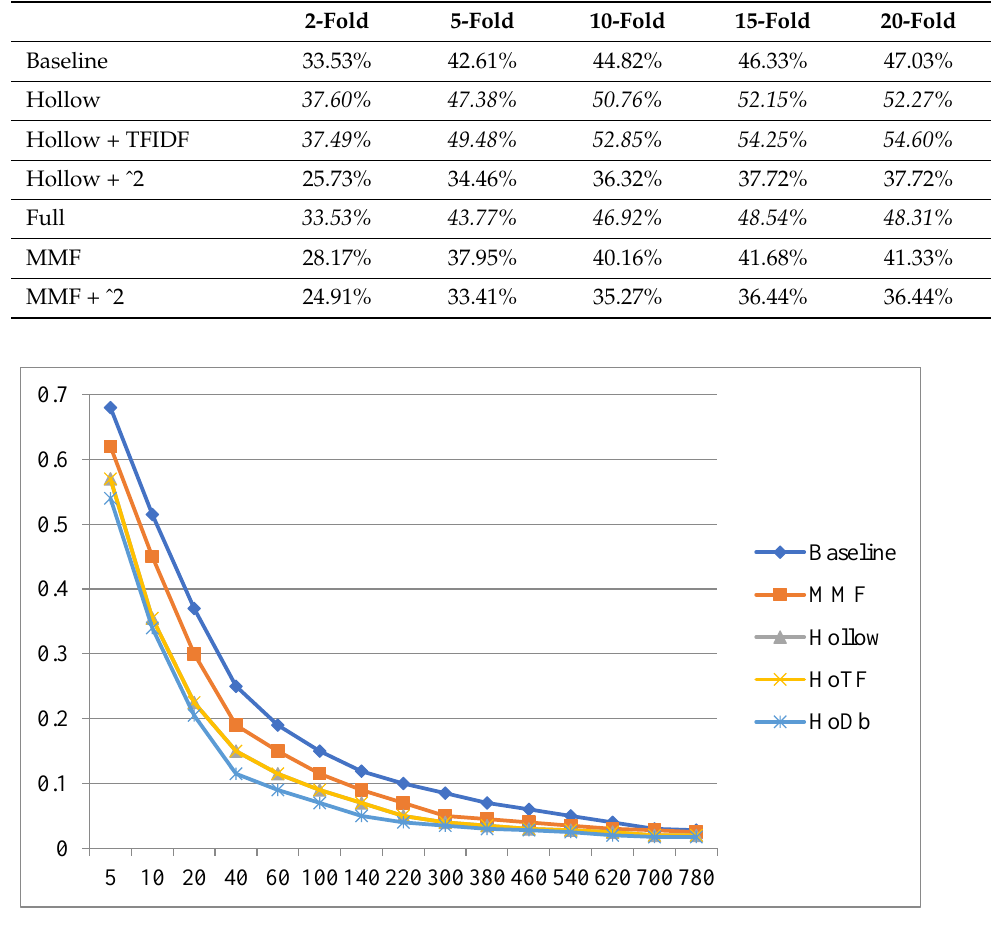
Figure 8. The precision rate of each feature representation method.